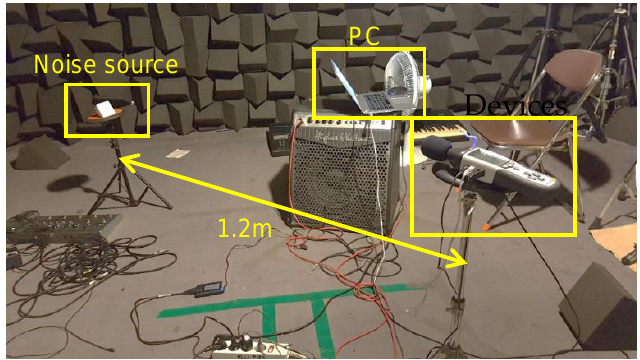
Sensors 2019 , 19 , x FOR PEER REVIEW Figure 11. Experimental setup for SPL measurement. Figure 11. Experimental setup for SPL measurement.